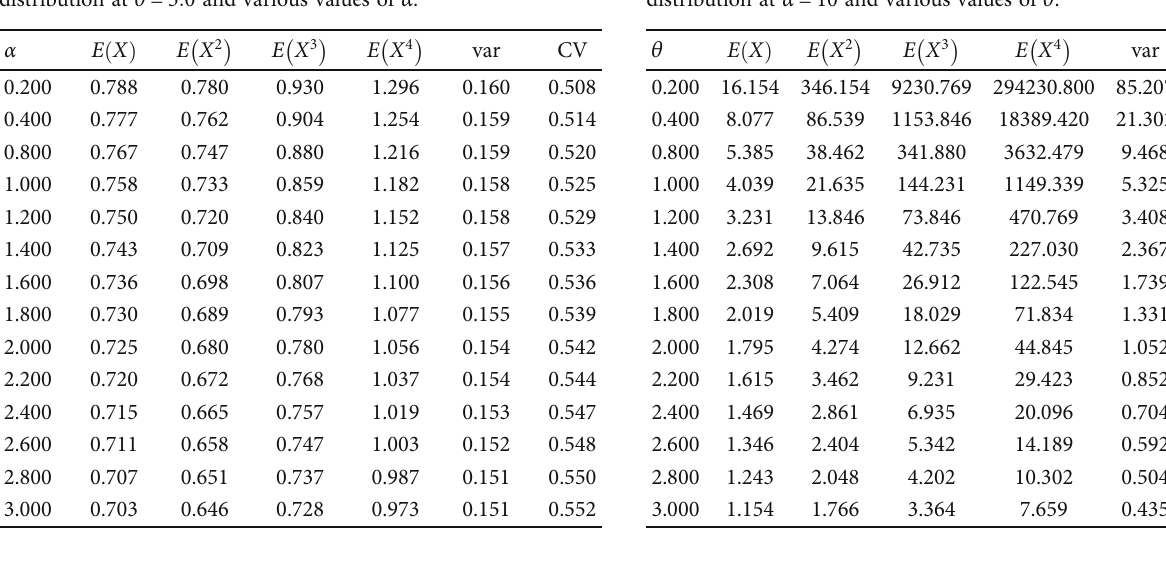
Table 6: Summary statistics of some moments of DWQL distribution at α = 10 and various values of θ